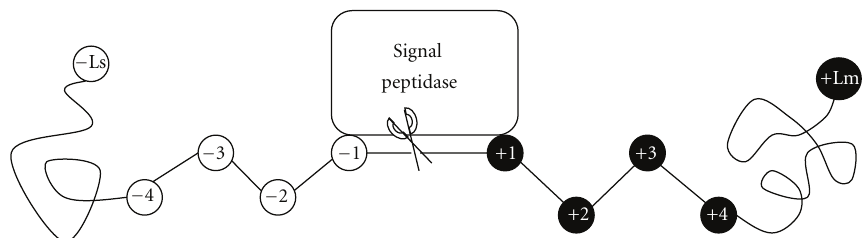
Figure 1: A schematic drawing shows the signal sequence of a protein and how it is cleaved by the signal peptidase. An amino acid in the signal part is depicted as a white circle with a black number to indicate its sequential position, while in the mature protein depicted as a black circle with a white number. The signal sequence contains Ls residues and the mature protein Lm residues. The cleavage site is at the position ( − 1,+1), that is, between the last residue of the signal peptide sequence and the first residue of the mature protein.